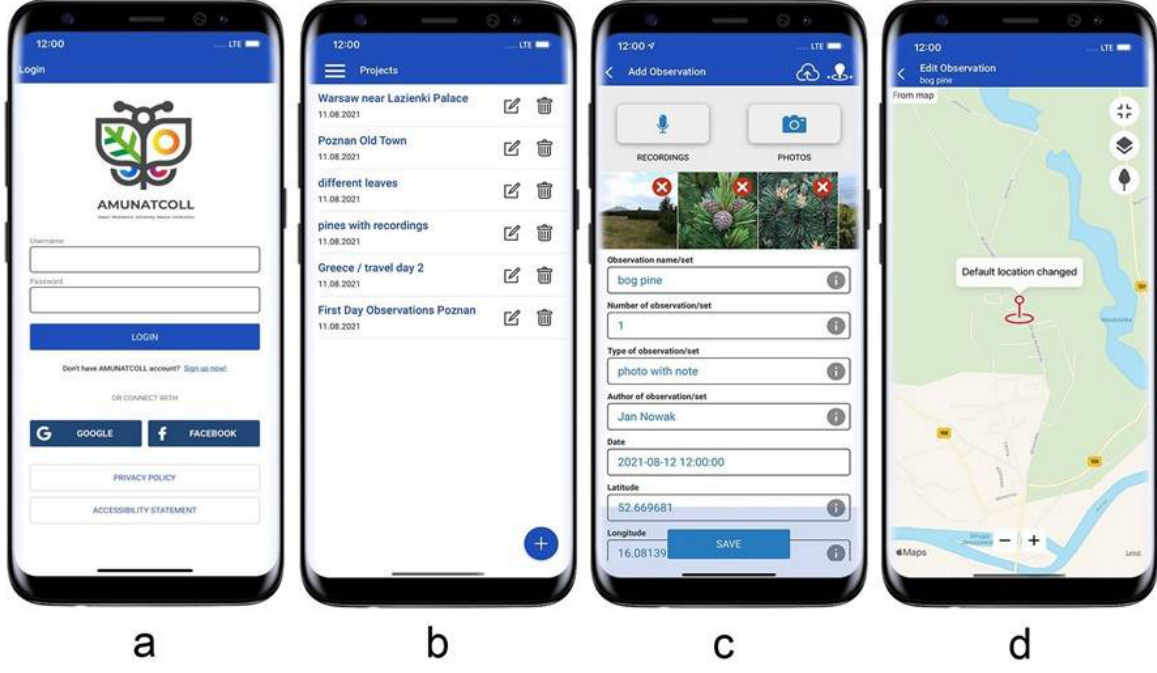
Figure 9. Selected screenshots of the AMUNATCOLL mobile application: ( a ) login screen, ( b ) screen with the list of projects, ( c ) observation screen, and ( d ) location of the observations on the map. https://apps.apple.com/pl/app/amunatcoll/id1523442673 and AMUnatcoll https://play.google.com/store/apps/details?id=pl.pcss.amunatcoll.mobile (accessed on 20 December 2021).